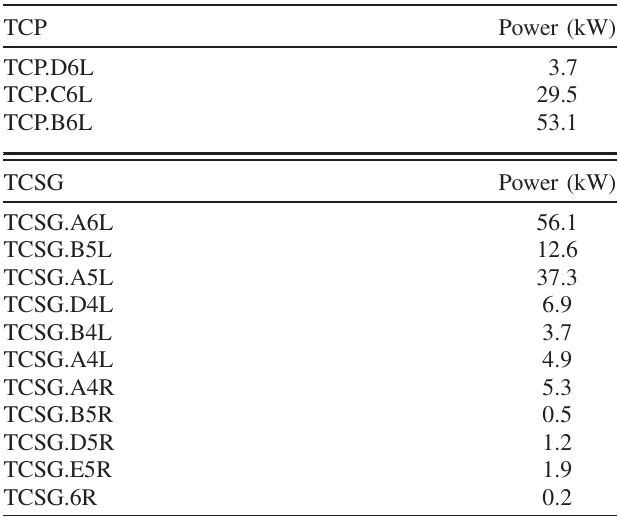
TABLE II. Total power taken by the collimators for 0.2 h BLT with total loss power of 1.86 MW.